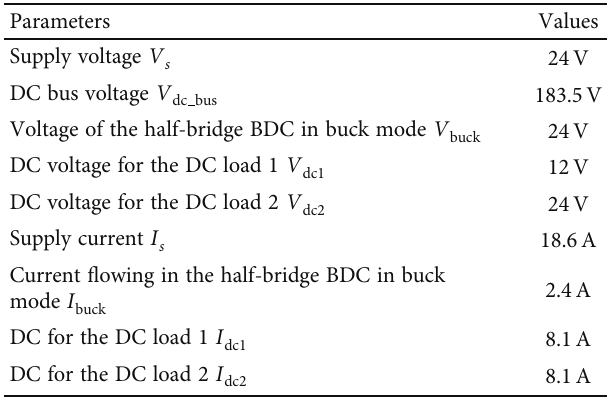
of the PV system-based DC microgrid operated with half-bridge buck Table 6: Parameters of PV system-based DC microgrid operated with half-bridge BDC in buck